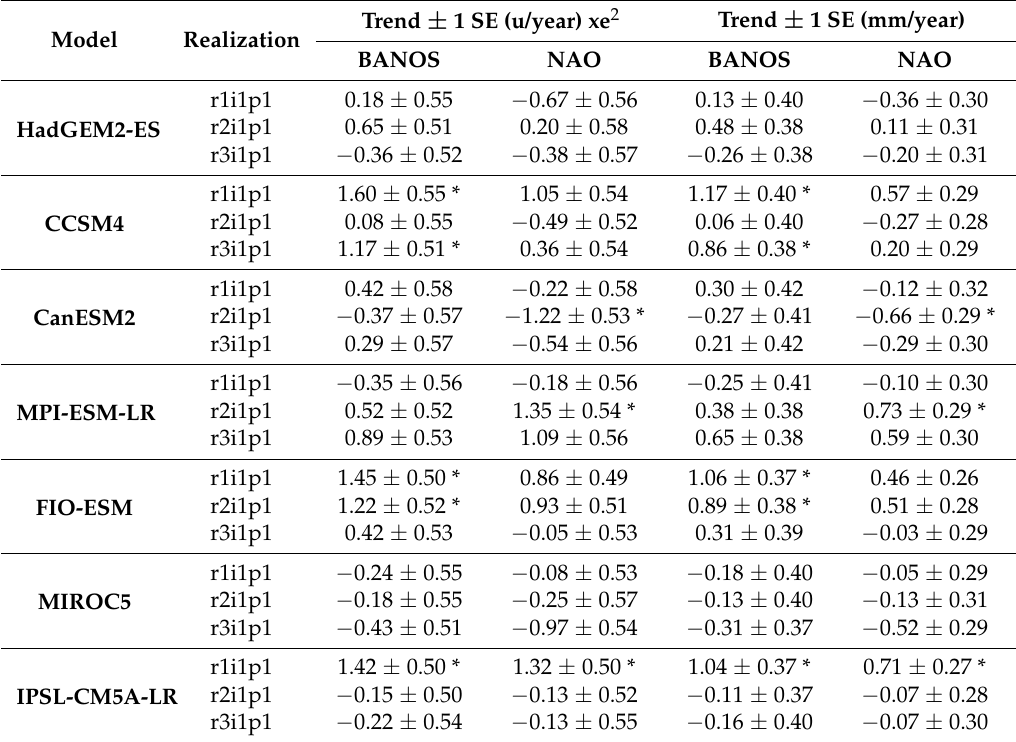
Table 4. Trends of the BANOS and NAO indices with their associated standard errors over the period 2006–2100. The significant trends at the 95% confidence level are marked (*). The letter ‘u’ stands for the word ‘Index Unit’. Last two columns at the right side refer to the sea-level trends in Stockholm due to trends in the corresponding atmospheric indices. For the associated trend of Warnemünde, sea-level trend estimations (mm/year) in the BANOS (NAO) column should be multiplied with the factor 0.32